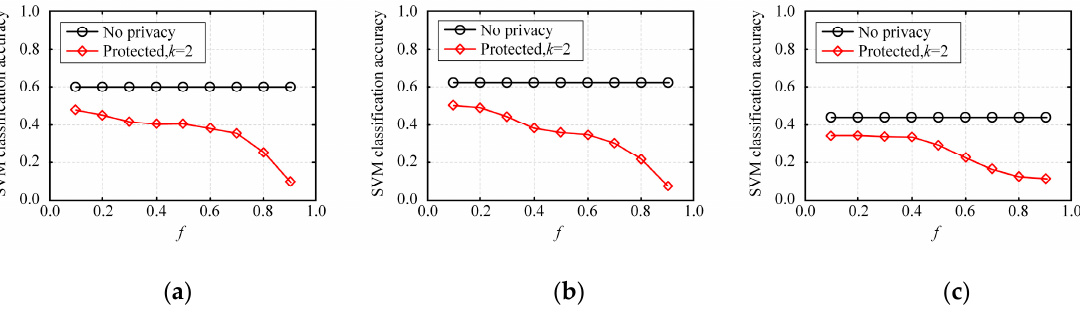
Figure 12. SVM classification accuracy by Multi-HM algorithm: ( a ) NLTCS, ( b ) Adults, ( c ) TPC-E.